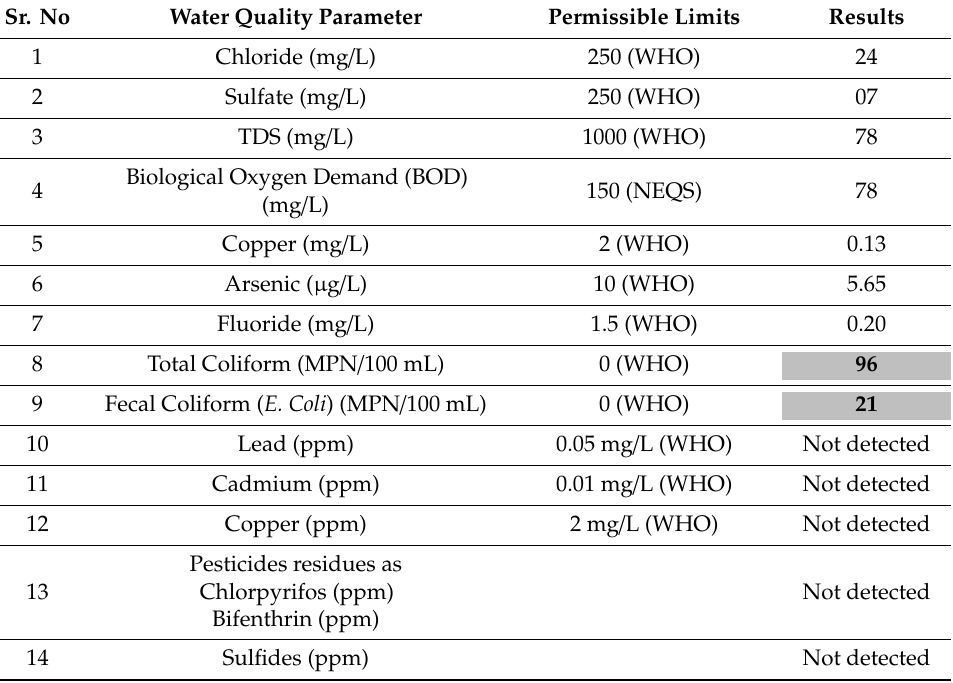
Table 3. Rainwater quality of collected samples at Gaddafi Stadium ponding site. Sr.